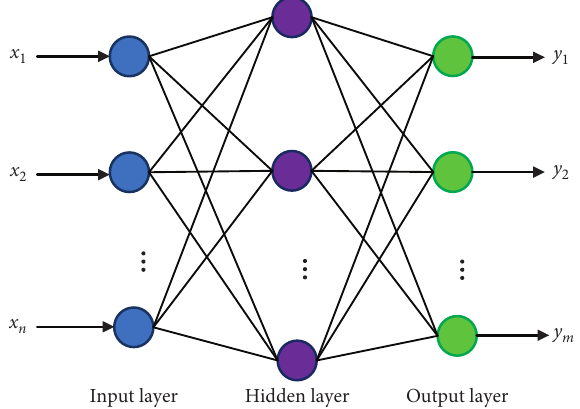
Figure 1: A schematic presentation of a backpropagation neural network